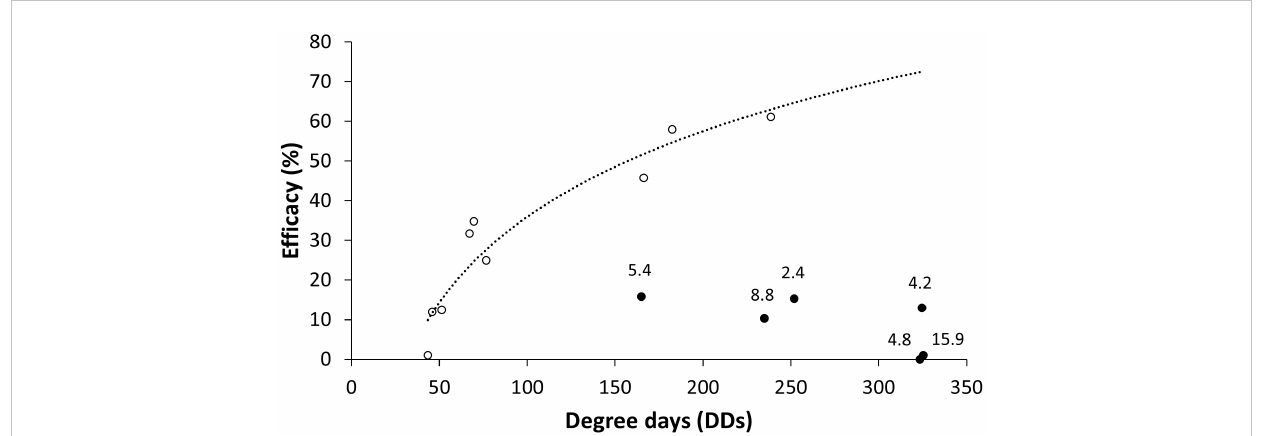
FIGURE 4 Relationship between the ef fi cacy (%) of treatments with biocontrol agents (BCAs) in reducing gray mold and degree-days (DDs) accumulated from application in the vineyard to the day after treatments when the berries were sampled, arti fi cially inoculated with a conidial suspension of Botrytis cinerea in the laboratory, and then incubated under optimal conditions for the pathogen for 1 week before disease severity assessment. Black and white dots represent ef fi cacy in rainy and non-rainy periods, respectively; numbers above black dots show the amount of rain accumulated (in millimeters). The dotted line represents the regression between DDs (x) and ef fi cacy (y) in the non-rainy periods: 31.154ln(x) − 107.56, R 2 = 0.91. Ef fi cacy was calculated in relation to an untreated